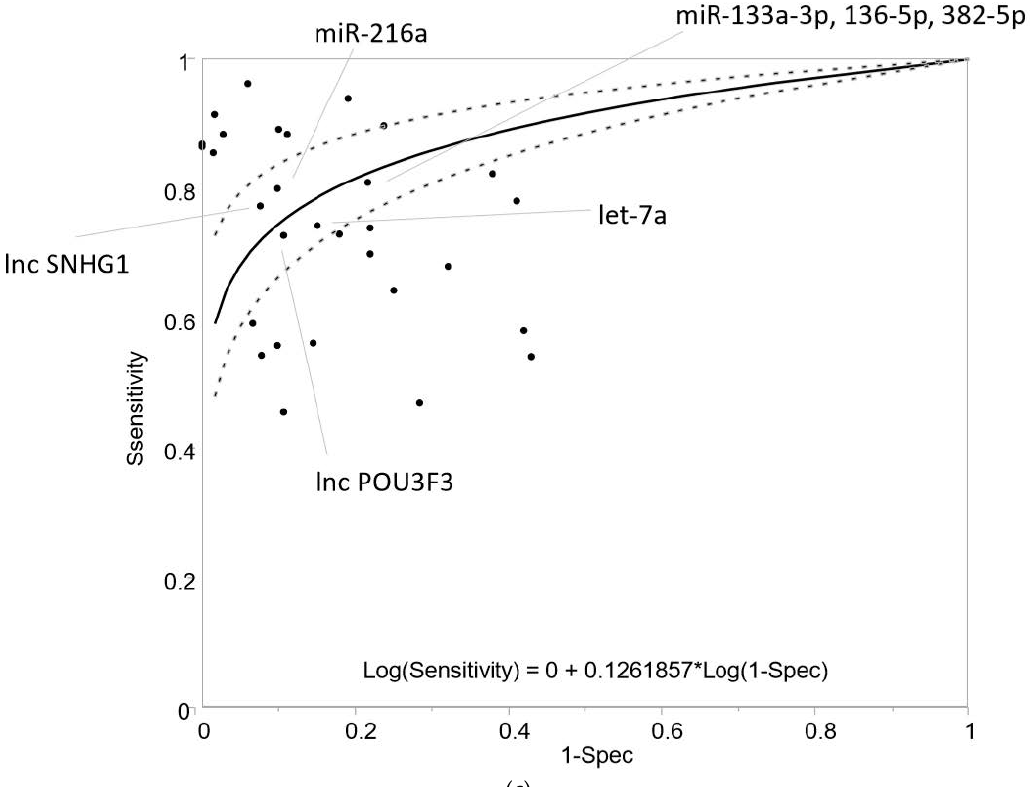
Figure 4. The diagnostic analysis of liquid biopsies. ( a ) Forest plot of the area under the curve; ( b ) funnel plot for the publication bias of ( a ); ( c ) the summary receiver operating characteristic (ROC) plot by sensitivity and 1-specificity for each of the molecules. The logarithmic regression curve was found to evaluate the heterogeneity of this analysis.